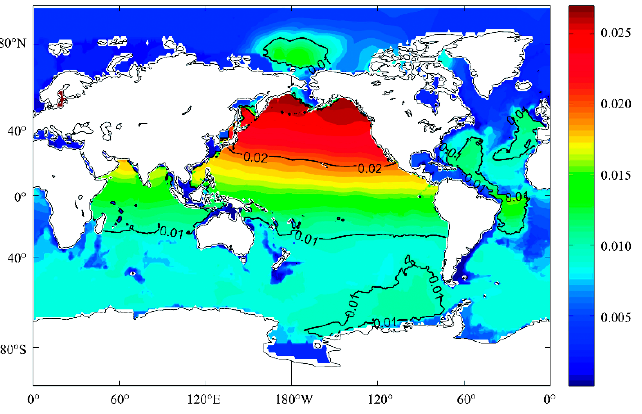
Figure 1. Maximum 𝛿𝑆 (cid:3002) in the world oceans (Data source: World Ocean Atlas 2009). Figure 1. Maximum δ S A in the world oceans (Data source: World Ocean Atlas